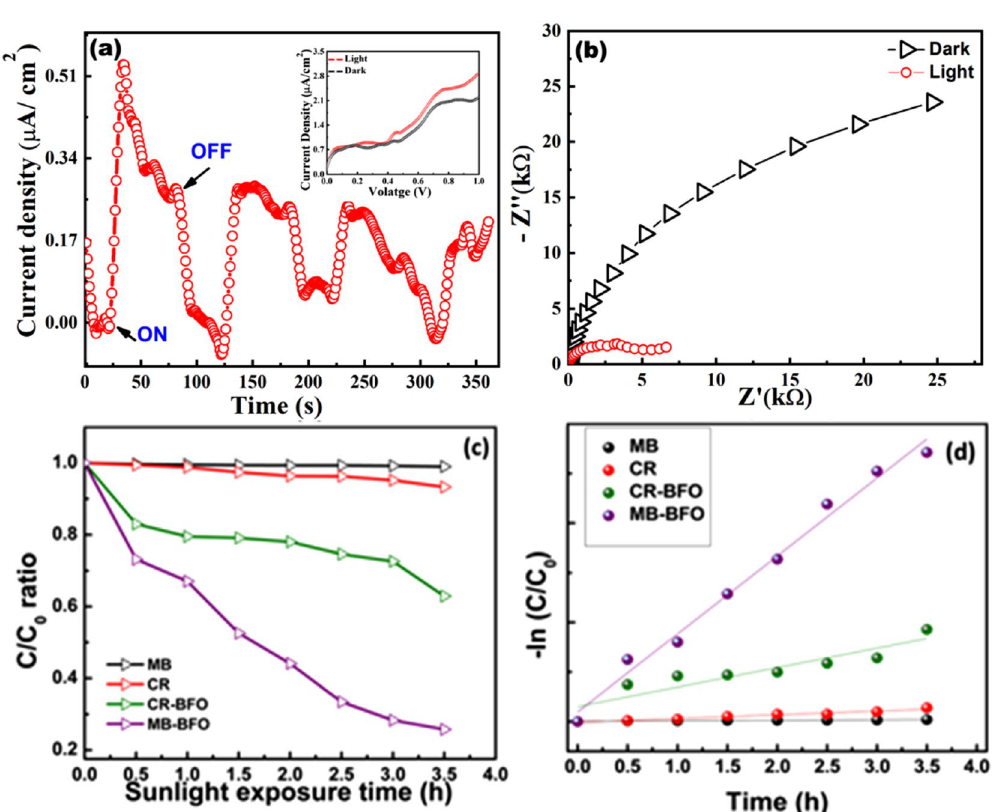
Figure 11. PEC studies on Bi 12 FeO 20 ( a ) Chronoamperometry curve, shows current response for ON/OFF states of light (inset dark and light I-V characteristics) ( b ) Impedance measurements under dark and light illumination ( c ) C/C 0 ratio graph of MB and CR dyes with and without catalyst ( d ) First order reaction kinetics for finding rate constant of MB, CR, MB-BFO and CR-BFO under sunlight